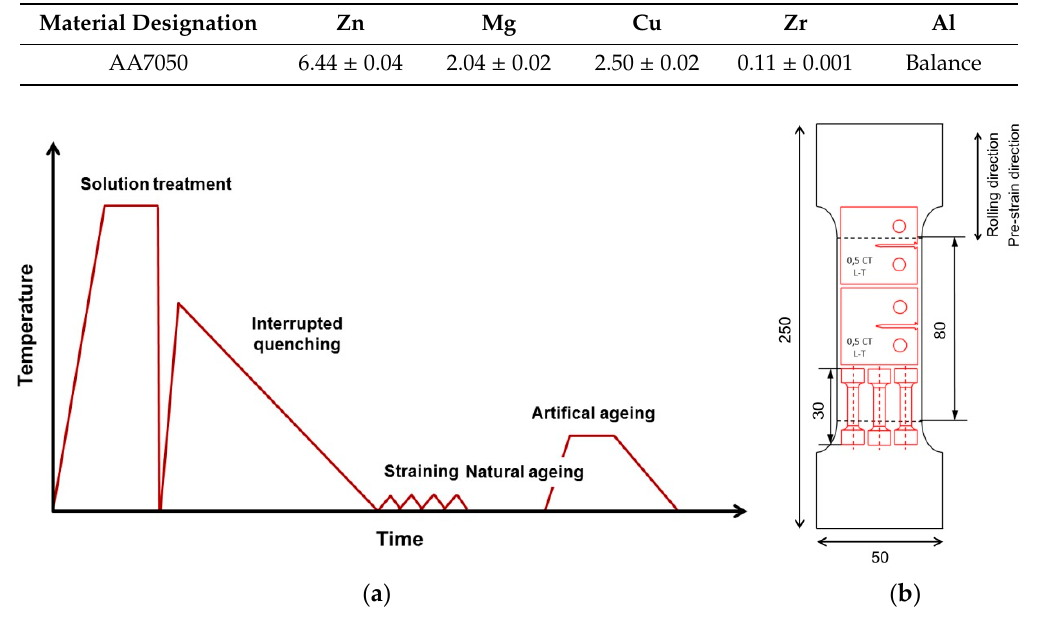
Figure 1. Schematic of the heat treatment during interrupted quenching (IQ) ( a ) [15] and sample geometries for mechanical testing specimens ( b ).